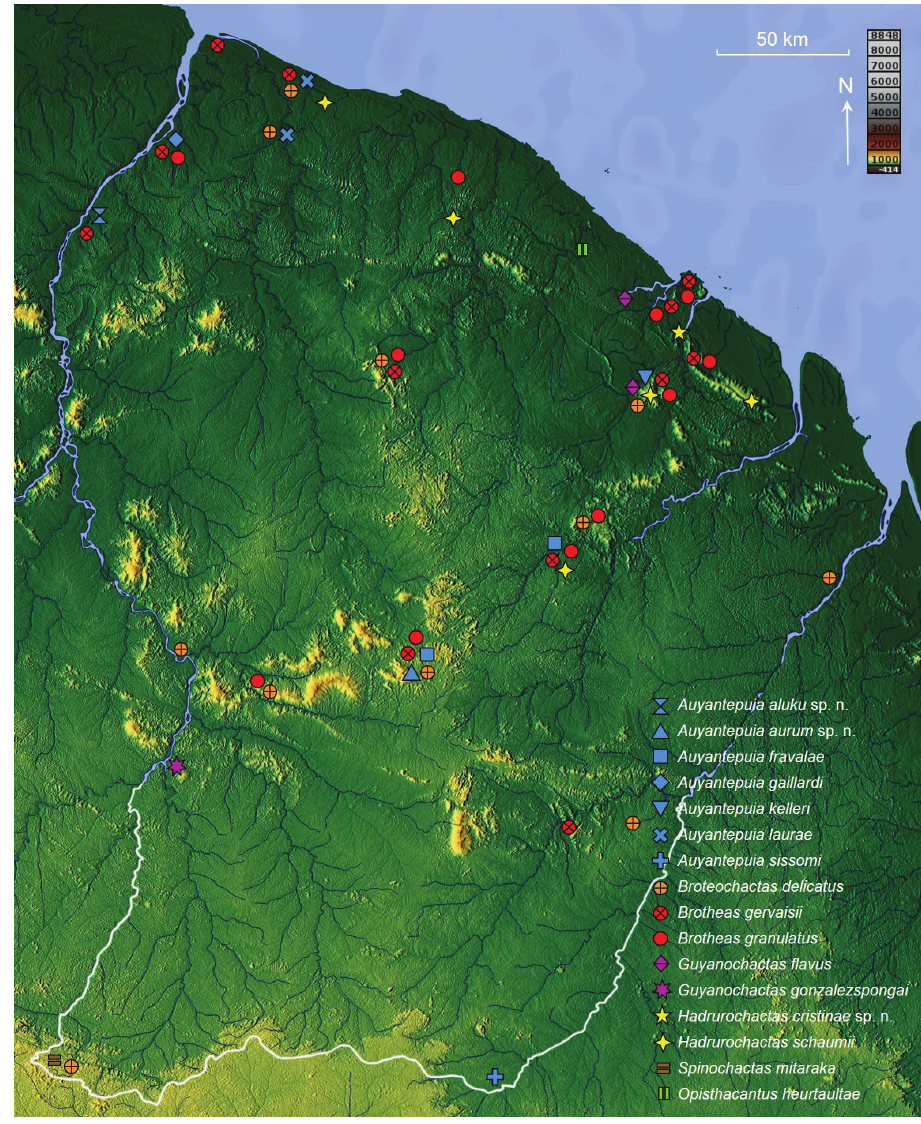
Figure 32. Topographic map of French Guiana showing the distribution of species of the families Chactidae and Hormuridae. yellow, the VII darker; pectines and genital operculum greyish yellow, lighter than the sternites. Metasomal segments dark reddish brown with some lighter zones forming reddish yellow spots. Vesicle yellowish, darker around the articulation with metasomal segment V; aculeus yellowish at the base and reddish at the tip. Chelicerae dark yellow with reddish fingers. Pedipalps reddish brown with some darker zones; fingers darker. Legs reddish brown with some lighter spots, yellowish. Carapace strongly